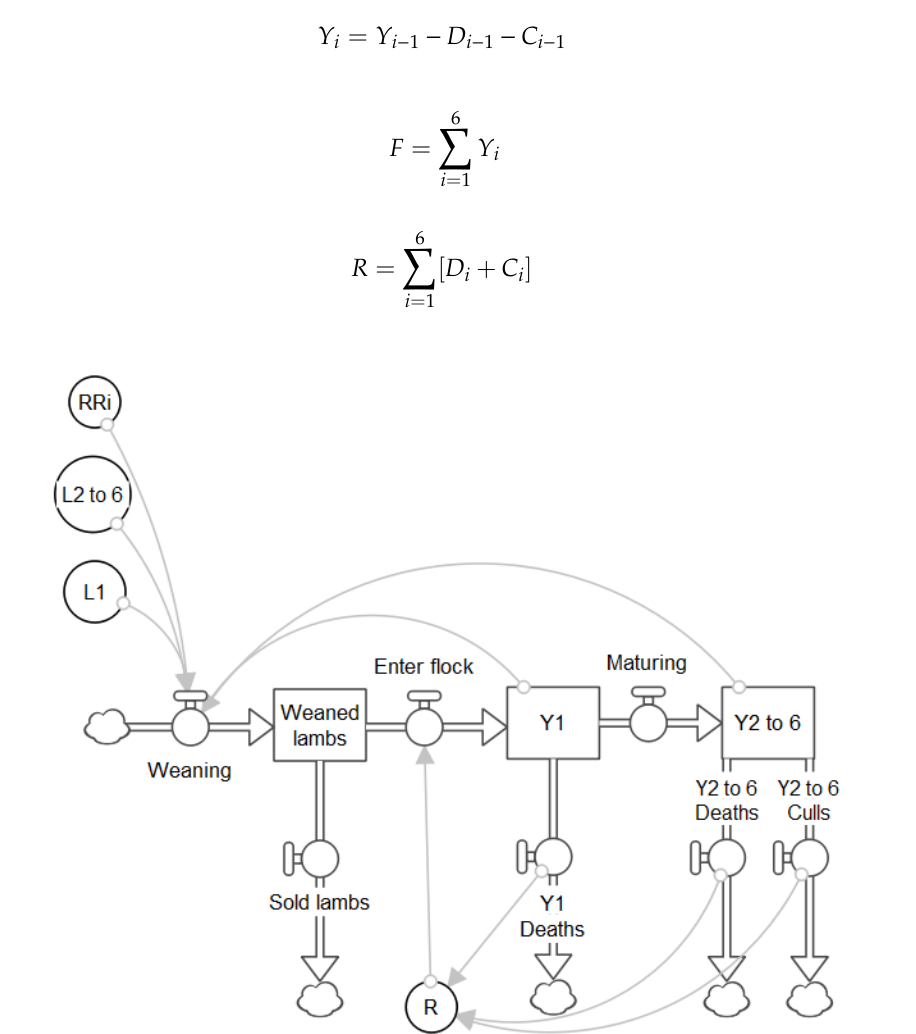
Figure 1. Simplified diagram of the flock dynamics module. Where numbers of Weaned lambs were a product of the numbers of ewes in each age ( i ) class ( Y i ) of the flock, the relative reproductive success (RR i ) of ewes in each age class, and weaning rate ( L i ). Numbers of replacement ewe lambs entering the self-replacing flock ( R ) were determined by numbers of ewes leaving the flock due to deaths and culling (with no culling of Y 1 ewes assumed and all live Y 1 ewes entered the mature flock). Numbers of lambs weaned ( LW ) were estimated from Equation (4) as a function of ewes of each age class presented for breeding ( Y i ), L (weaning rate as lambs weaned per ewe presented for breeding), and relative reproductive success for each ewe age class ( RR i ; RR 2 = 0.85 , RR 3 = 0.98 , RR 4 = 1.07 , RR 5 = 1.12 , and RR 6 = 1.09 ; as detailed in [18]). The flock weaning rate (FWR for Y 2 to 6 ewes) was modelled at two levels, firstly at 132% which was the average 2017/18 rate for the farm system under study [21]. In order to investigate the value of breeding hoggets for farms with a more productive flock, FWR was also modelled at 150%. This FWR of 150% was approximately the 90 th percentile of weaning rates achieved in 2017 by flocks on New Zealand North Island Hill Country farms [24]. Hogget weaning rate (HWR) was varied to RR 1 = 0, 0.6, 0.8, or 1. Responses to a questionnaire sent to